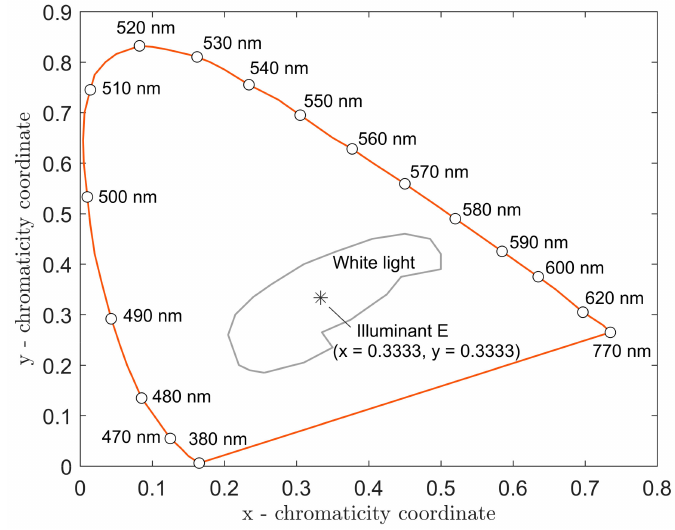
Figure 2. Color diagram scheme International Commission on Illumination (CIE) 1931 ( x , y